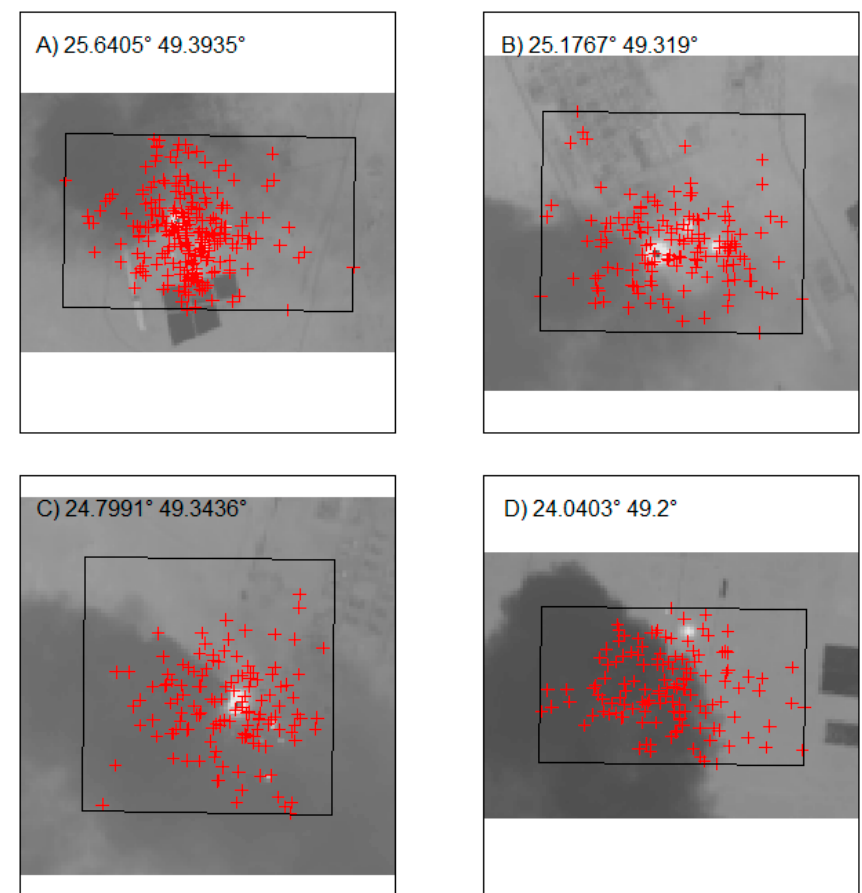
Figure 2. Active fire detection locations from Moderate Resolution Imaging Spectroradiometer (MODIS) Aqua, Terra and Visible Infrared Imaging Radiometer Suite (VIIRS) are shown as red crosses over the four ( A – D ) flares illustrated in Figure 1. Central geographic coordinates are shown for each flare site illustrated in Figure 1 is also shown in each frame. The black box is the smallest spatial extent that encompasses all detections in the study period. Background Landsat 8 2.2 µ m band 7 reflectance over the extents padded by 1 km is shown to provide spatial context.